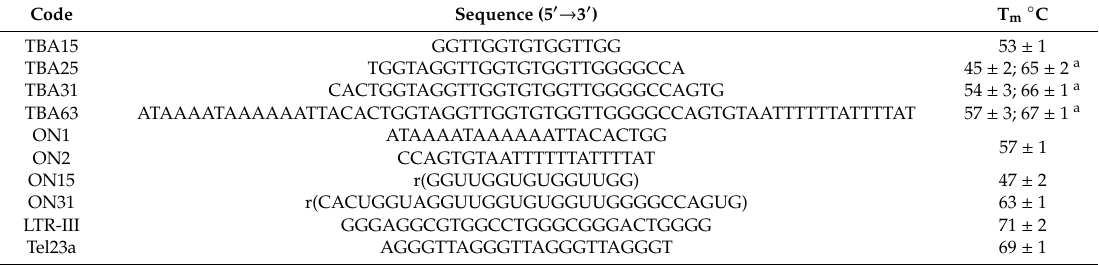
Table 1. Oligonucleotide sequences and melting